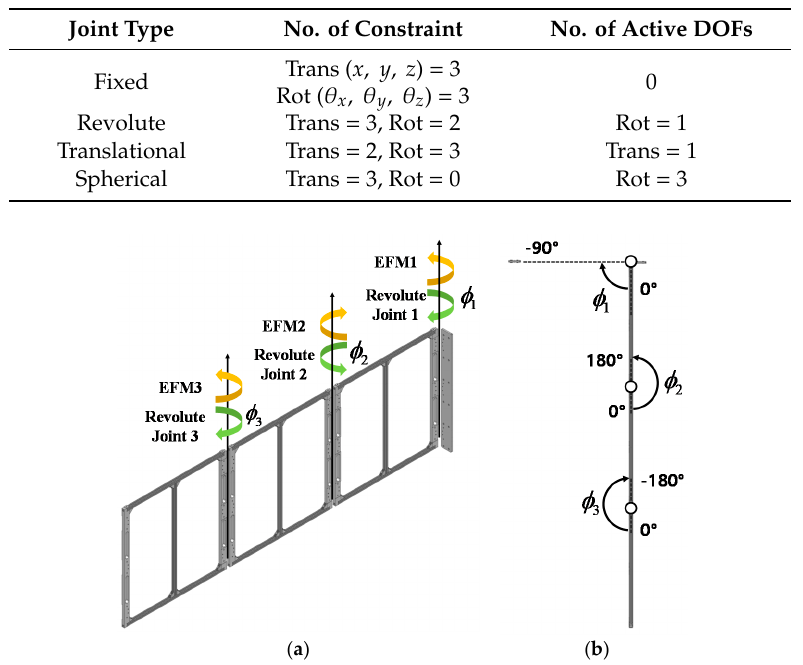
Table 4. Number of constraints and active DOFs of various types of joints.